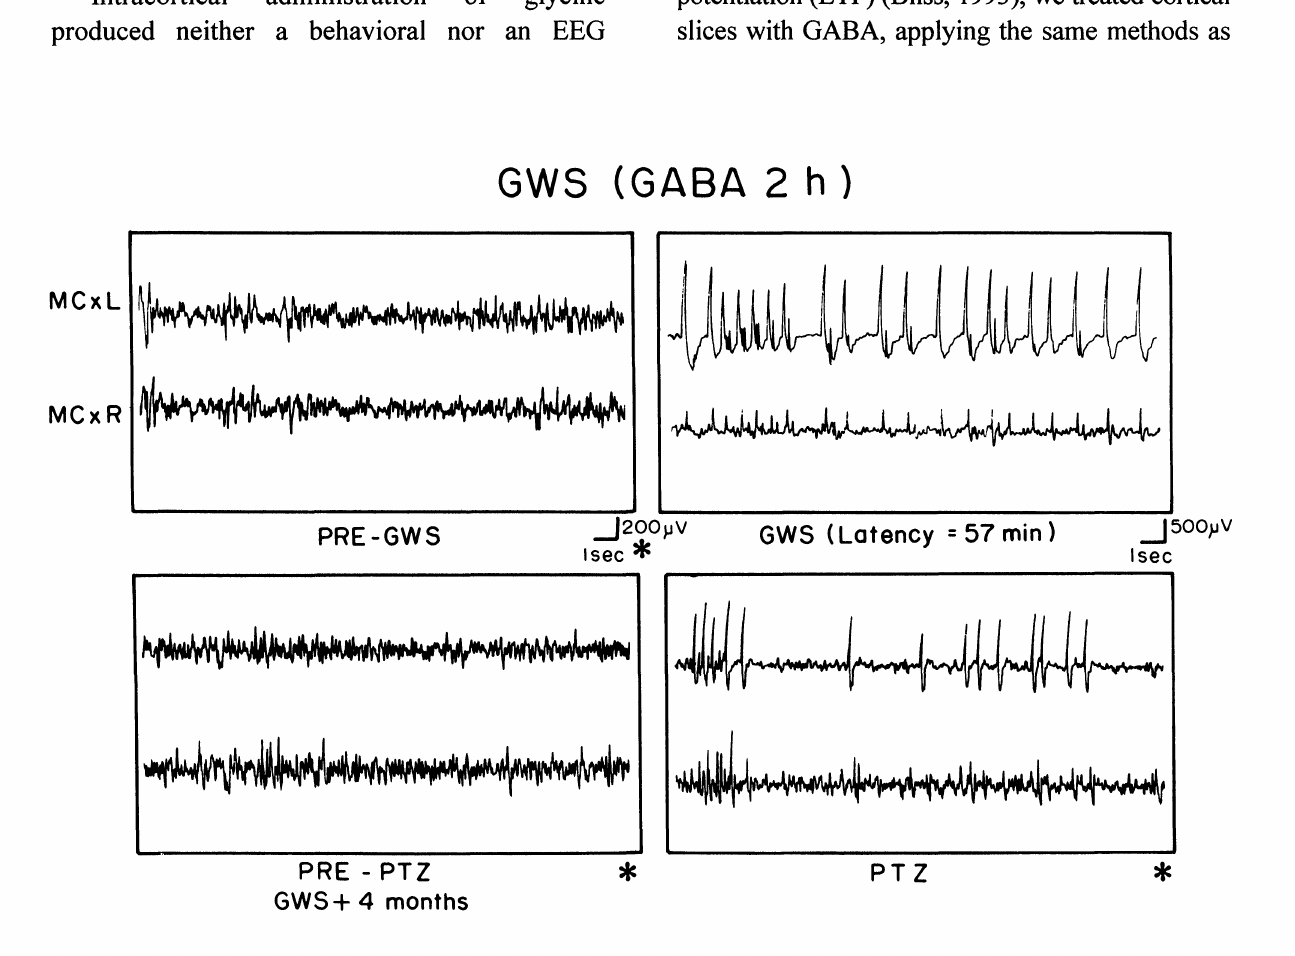
Fig. 2: An example of the electrographic changes typical of a GWS induced after 120 min of continuous intracortical GABA infusion. GABA was applied into the left somatomotor cortex (MCx). The effects of i.p. injection of pentylenetetrazol (20 mg/kg) 4 months after the disappearance of electrographic signs of GWS epileptogenesis are also shown. Note the reactivation at the cortical focus, with characteristics similar to those observed